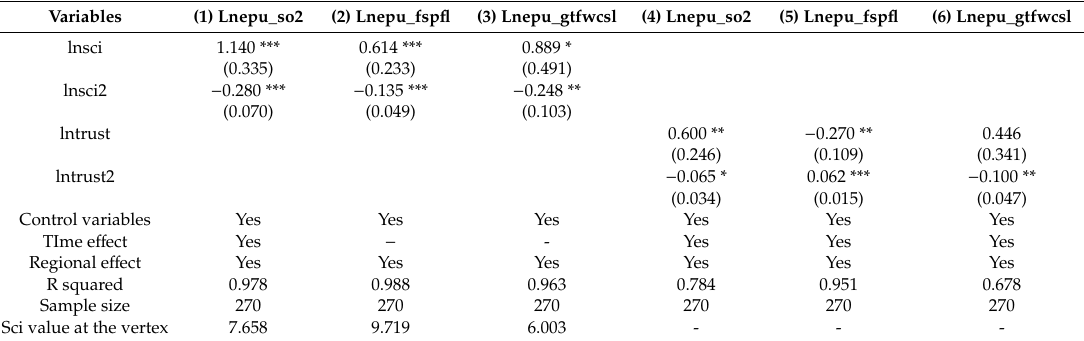
Table 4. Regression results of environmental pollution